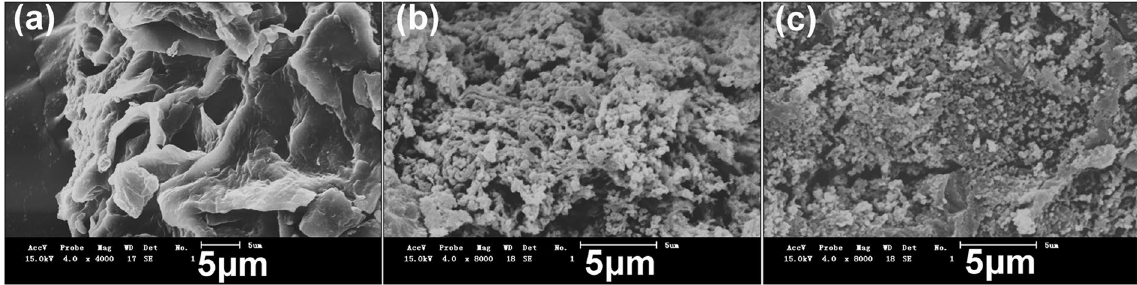
Figure 2. SEM images of ( a ) SR–PAA; ( b ) SR–PAA–Cd and ( c ) SR–PAA–Pb.